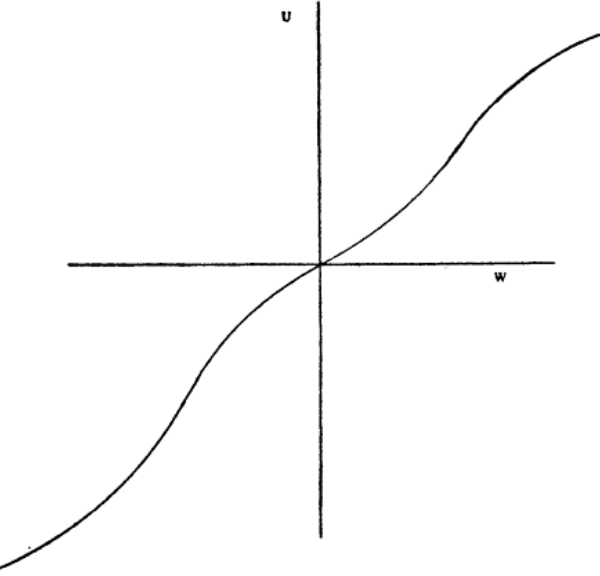
Figure 5. Markowitz’s triply inflection curve